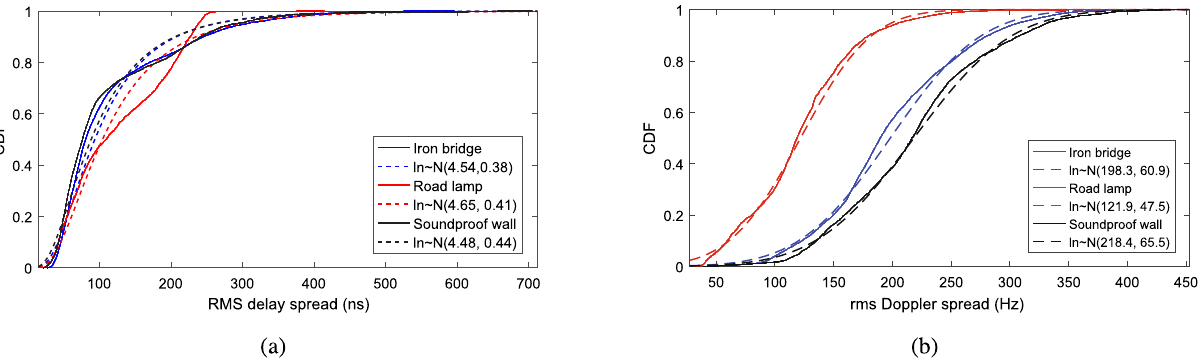
Figure 5. Cumulative distribution function of the rms delay spread and the rms Doppler spread. ( a ) rms delay spread. ( b ) rms Doppler